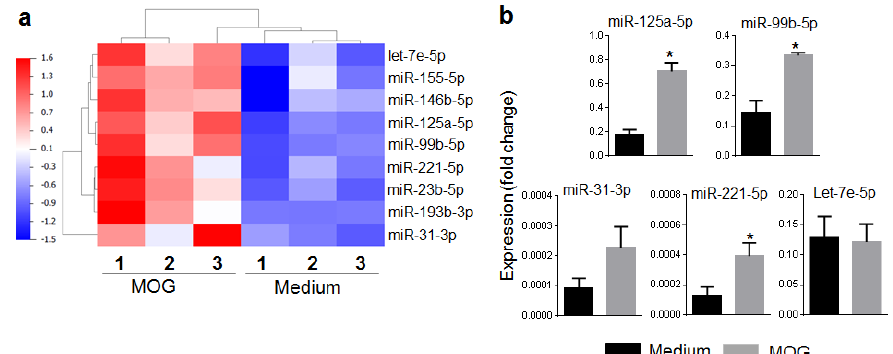
Figure 2. Top-listed miRNAs. ( a ) Heatmap of top-listed miRNAs showing significant difference in their expression profiles when comparing MOG 35–55 -restimulated splenocytes vs. medium control ( p < 0.05, and fold change >2). It was derived from the heatmap shown in Figure 1. Blue color represents low, while red color represents high expression levels; ( b ) qRT-PCR validation of selected miRNAs shown in ‘a’ and presented here as ‘fold change’ over the medium control ( n = 3–4 for different miRNAs). Total RNA was used for quantification of mature miRNAs using TaqMan MicroRNA Assays kit (Life technologies, Carlsbad, CA, USA) according to the manufacturer’s protocol. A single-stranded cDNA specific for miRNA to be tested was synthesized from total RNA, and it was amplified using sequence-specific primers. The specific miRNA levels were normalized using U6 as control and the results expressed as ‘fold change’. (* p < 0.05).